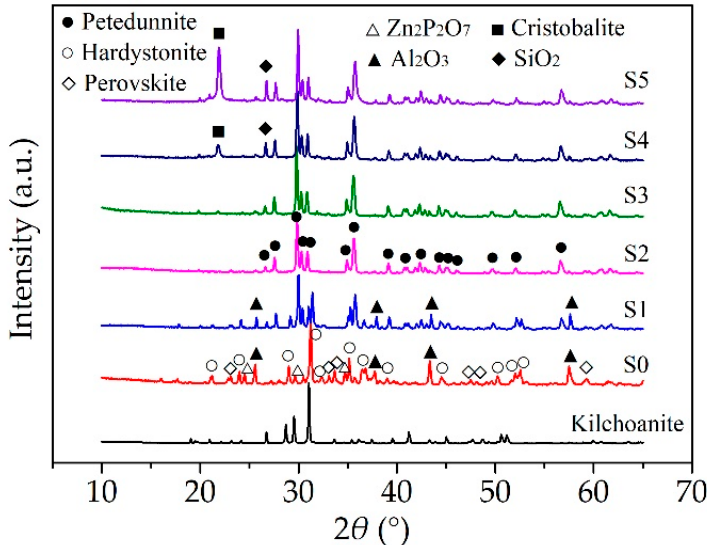
Figure 5. XRD patterns of the sintered samples with different contents of nano silica.